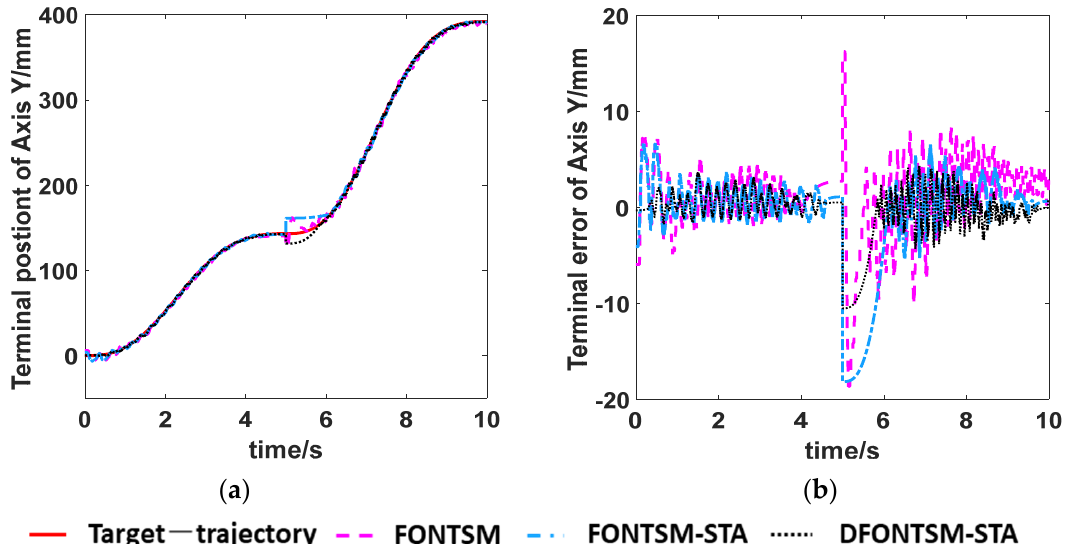
Figure 16. Terminal trajectory and its tracking error. ( a ): terminal trajectory on the Y axis; ( b ): terminal tracking error on the Y axis.